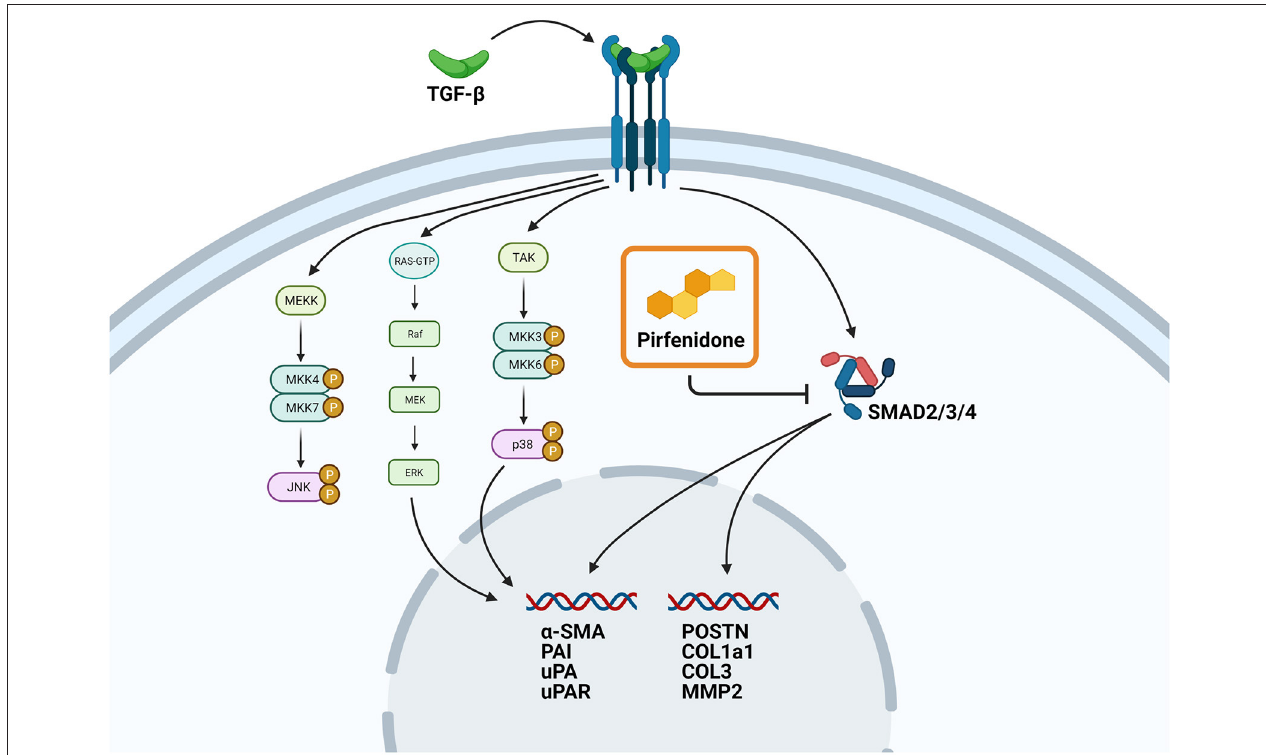
FIGURE 6 | Proposed mechanism of action of pirfenidone. Schematic overview showing the proposed role of pirfenidone in CTC. Upregulation of pro-fibrotic gene expression through the canonical TGF- β pathway is blocked by pirfenidone, but upregulation of pro-fibrotic gene expression through the non-canonical pathway is still